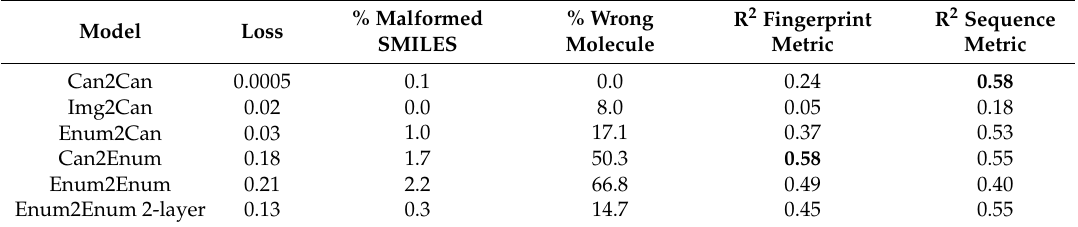
Table 1. Properties of the models trained on different input and output representations of the GDB-8 dataset. All values were calculated using the test dataset. Strings in the simplified molecular-input line-entry system (SMILES) notation were consideret malformed if they could not be parsed to molecules by RDKit